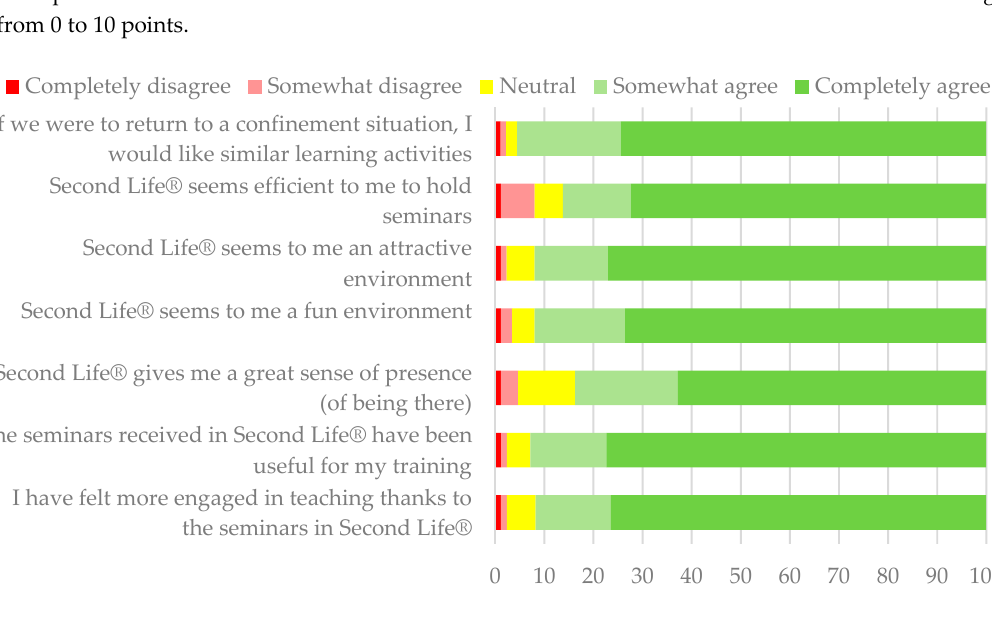
Figure 1. Bar chart of the percentages of answers in a 5-point Likert scale related to questions about radiology seminars held in Second Life ® . Sample: 90 students (41% enrolled in the